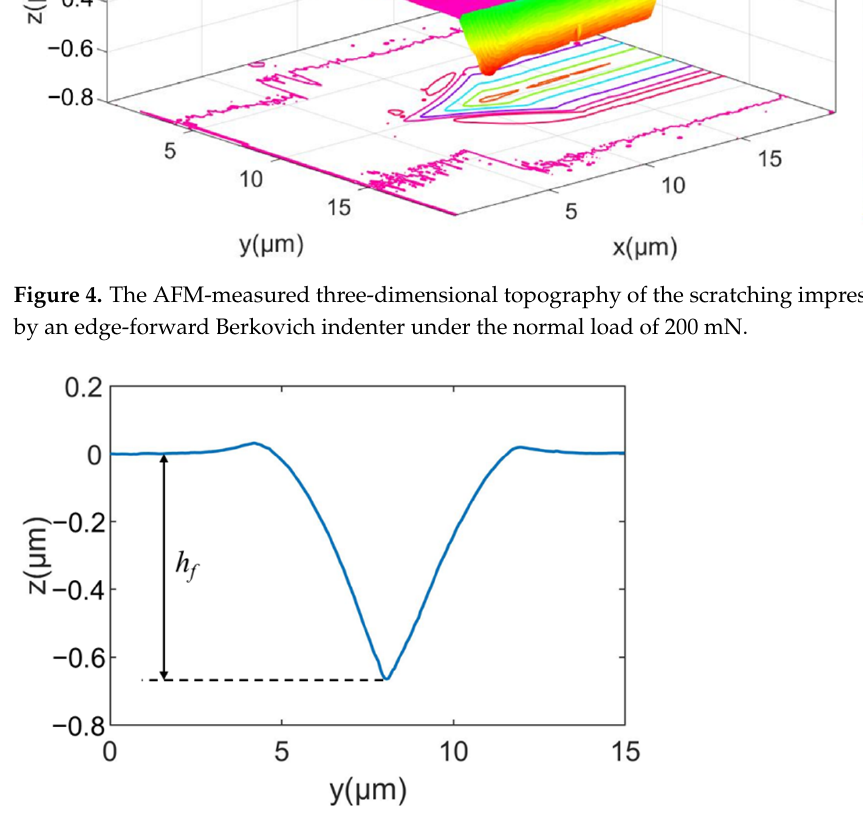
Figure 5. The average cross-section profile of the scratching impression.